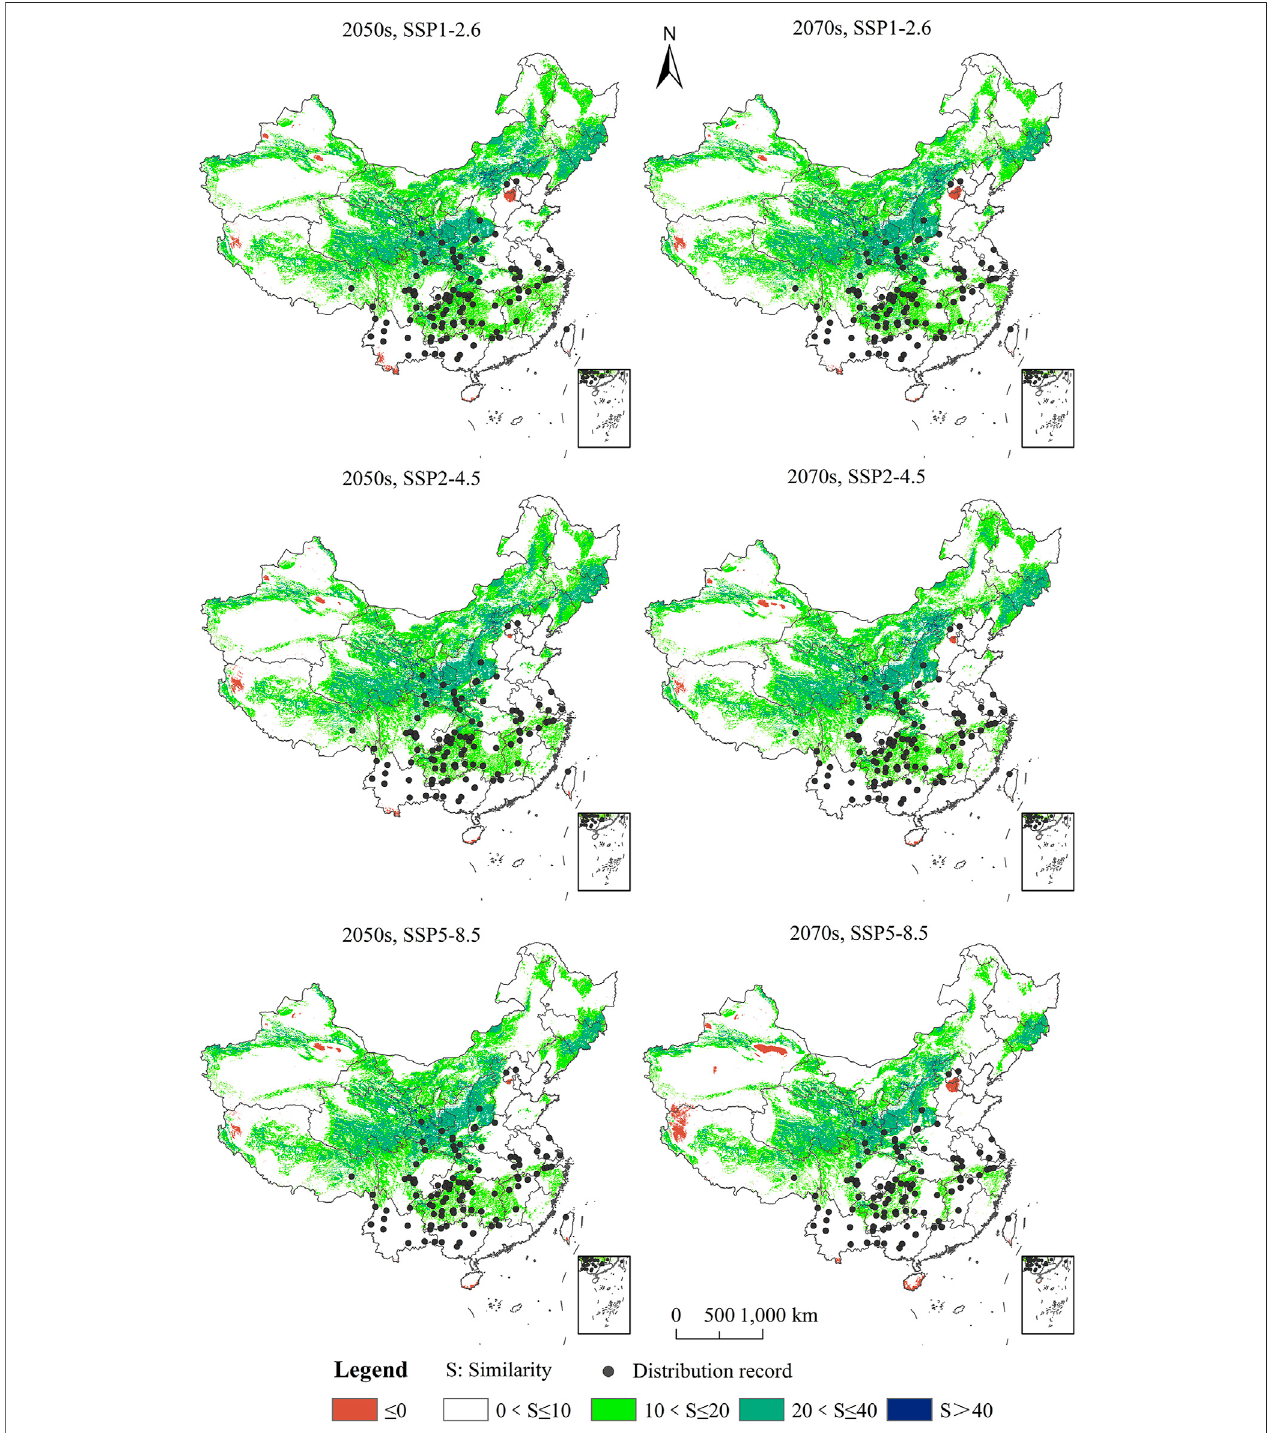
FIGURE 6 | Analysis of the Multivariate Environmental Similarity Surface (MESS) of the potential distribution area for Cremastra appendiculata under future climate changes.